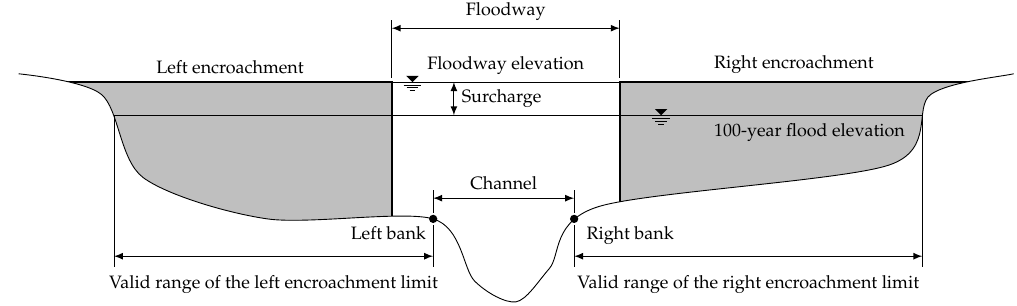
Figure 1. Schematic of the 100-year flood elevation and